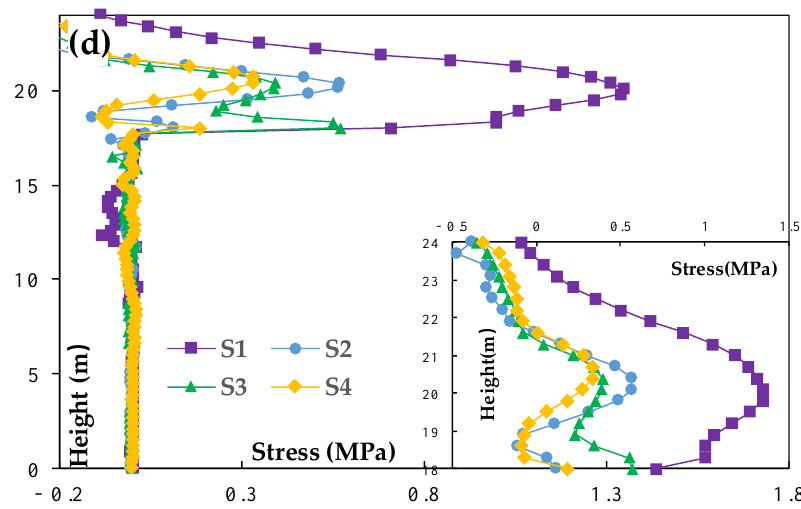
Figure 9. Stress evolution in the CPB stope induced by blasting in an adjacent ore stope: ( a ) the first lift blast; ( b ) the secondary lift blast; ( c ) the third lift blast; ( d ) the fourth lift blast. The von Mises stresses of the ore and CPB elements at the observation points